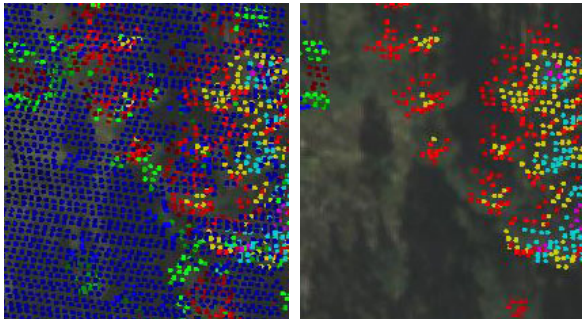
Figure 9. In some cases, hiding some of laser points can enchant interpretability. The left image illustrates all ALS points and the right image only points measured from the higher parts of the tree